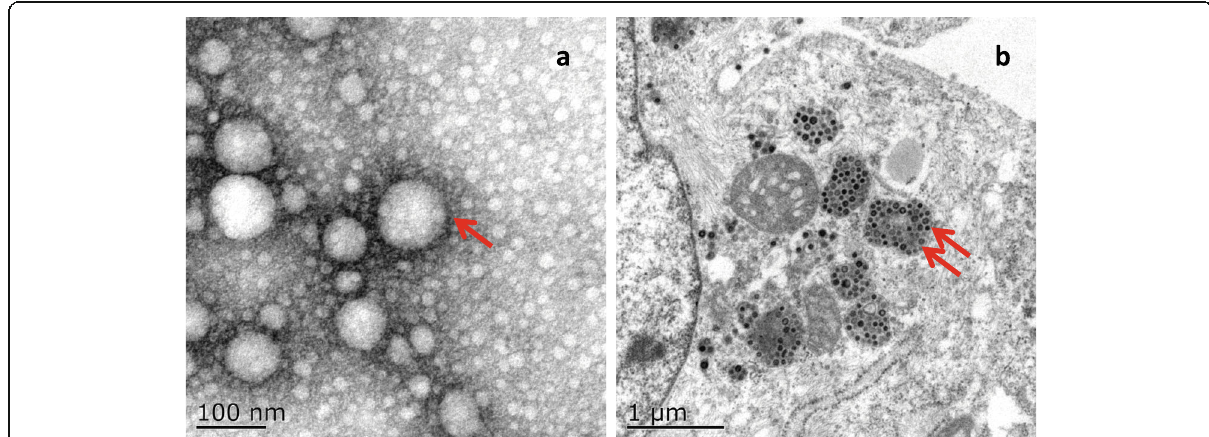
Fig. 4 Detection of CCoV under electron microscopy. a, Negative staining of CCoV particles from CCoV JS1706-infected cell culture supernatant. The red arrow indicates corona spikes of CCoV particles. Scale bar, 100 nm. b, Ultrathin sections of A-72 cells infected with CCoV JS1712 24 h post infection. The red double arrow indicates virions present in the inclusion bodies in cytoplasm. Scale bar, 1 μ m